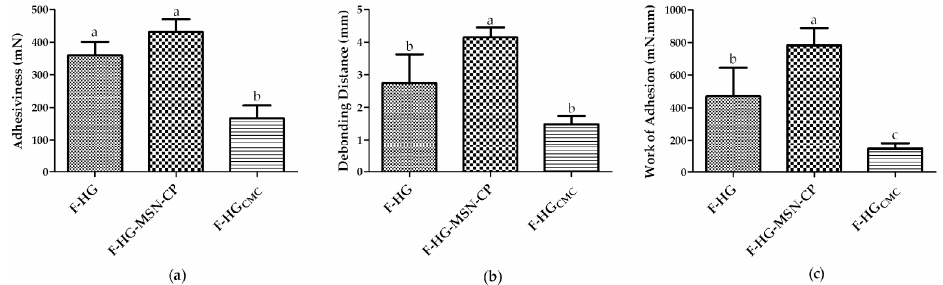
Figure 11. Bioadhesion measurements: ( a ) adhesiveness (mN), ( b ) debonding distance (mm) and ( c ) work of adhesion (mN · mm) of the 3D-printed films (F-HG, F-HG-MSN-CP and F-HGCMC). Data represent mean ± SD, n = 3. One-way ANOVA and Tukey post hoc test. Means with different letters denote statistical difference ( p ≤ 0.05).